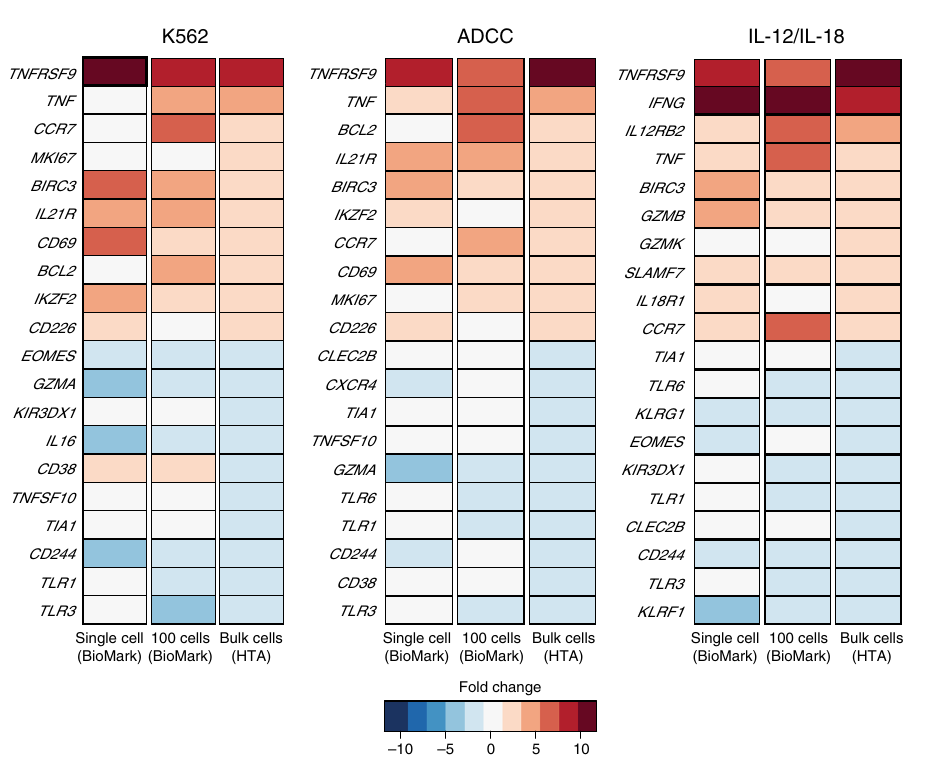
Fig. 4 Gene expression of responding NK cells at single-, 100-cell, and whole-transcriptome levels. Gene expression heat map displaying top 10 upregulated and top 10 downregulated of 96 pre-selected genes involved in NK responses across stimulation conditions, ranked by fold change. Each column represents expression at the single-, 100-, and bulk-cell levels. Data represented are from three donors and three stimulation conditions, K562, ADCC, and IL-12/IL-18. Expression threshold (ET) values were calculated based on CT values (40-CT) obtained from the qPCR data and fold change was determined by comparison of ET